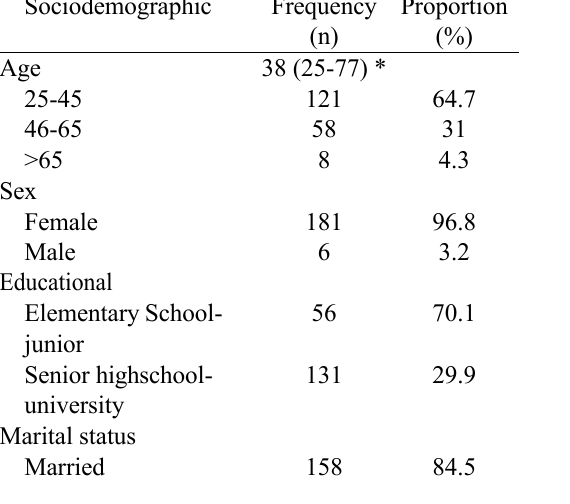
Table 1. Sociodemographic data of the household (n=187) Sociodemographic